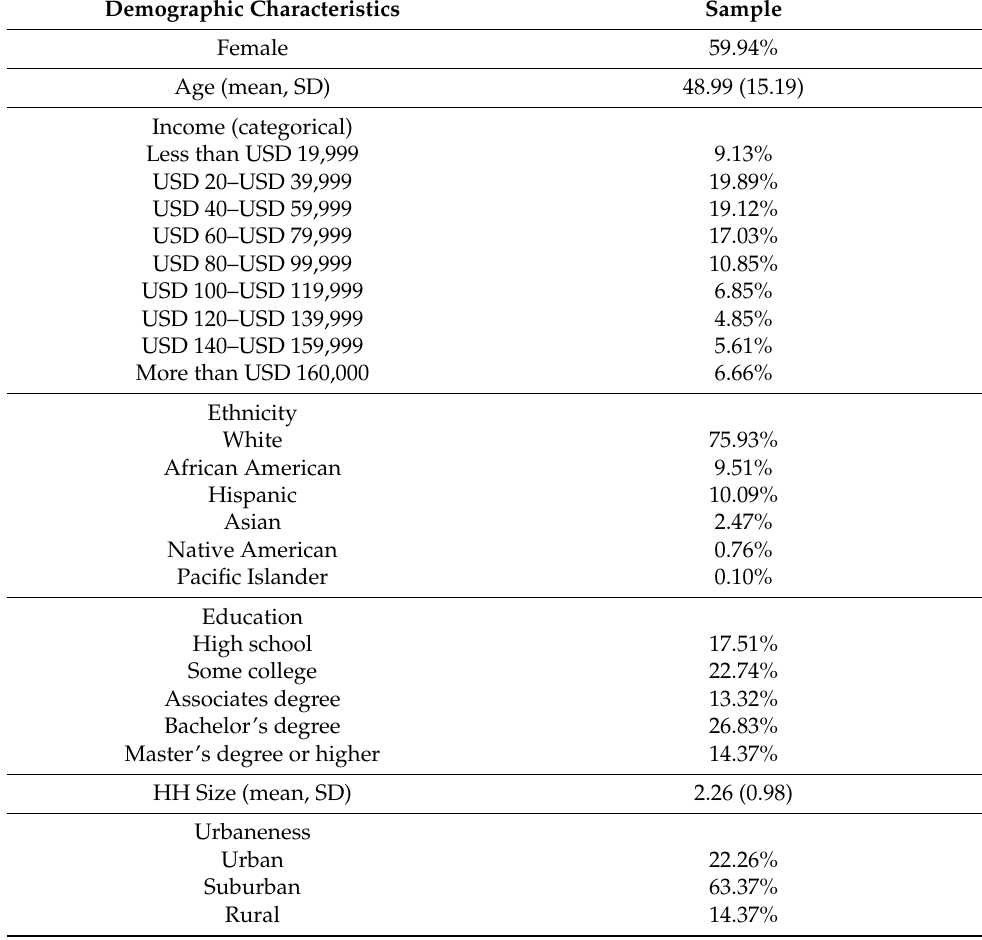
Table 2. Online Survey Sample Demographic